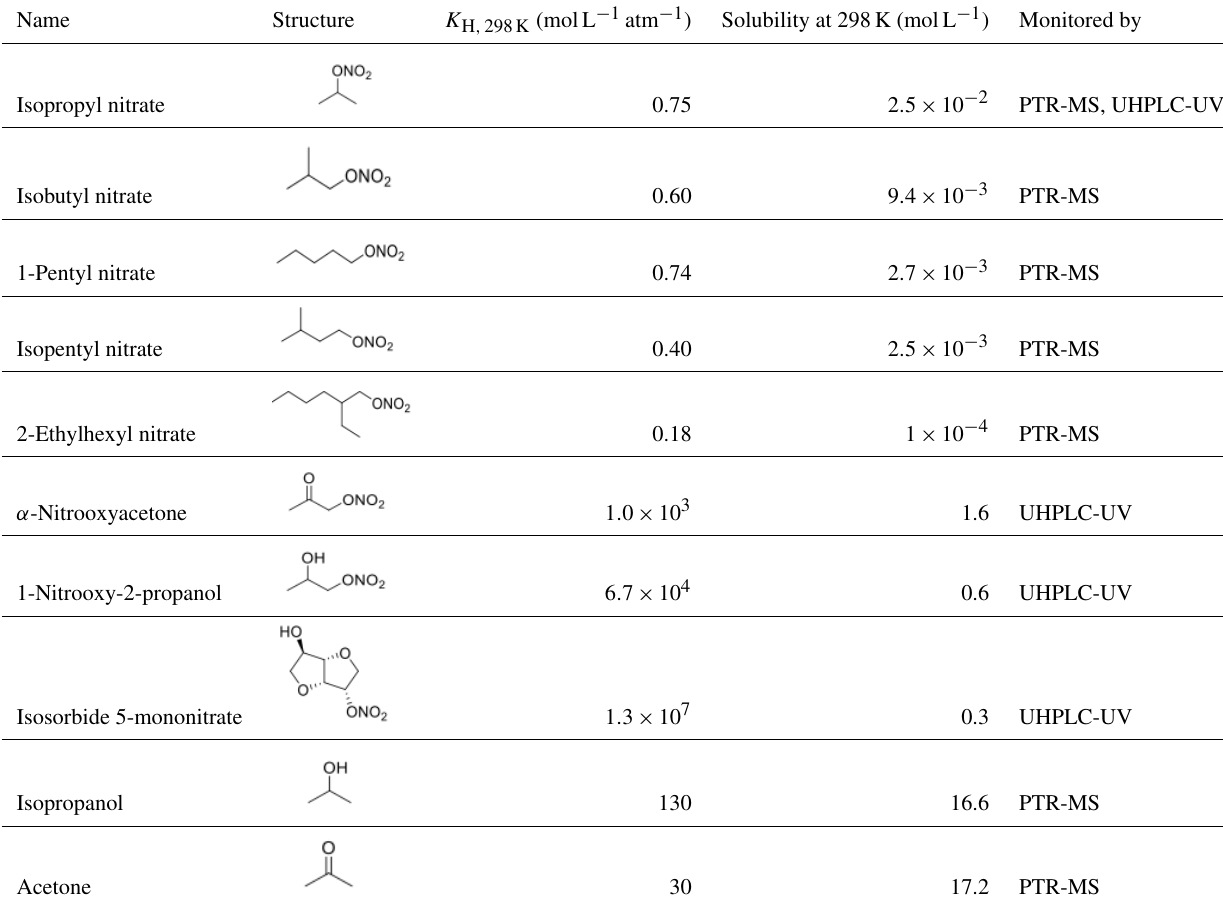
Table 1. Chemical structures and properties of the studied organic nitrates. Henry’s law constants were obtained from Sander (2015) except for 2-ethylhexyl nitrate and isosorbide 5-mononitrate, which were calculated using the SAR developed by Raventos-Duran et al. (2010). Organic nitrate solubilities were calculated using the model